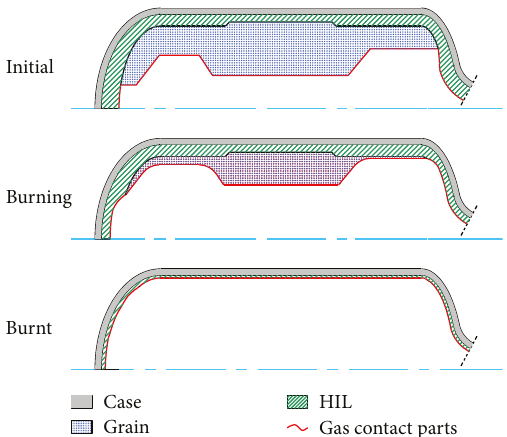
Figure 1: Burning and recession of the grain and